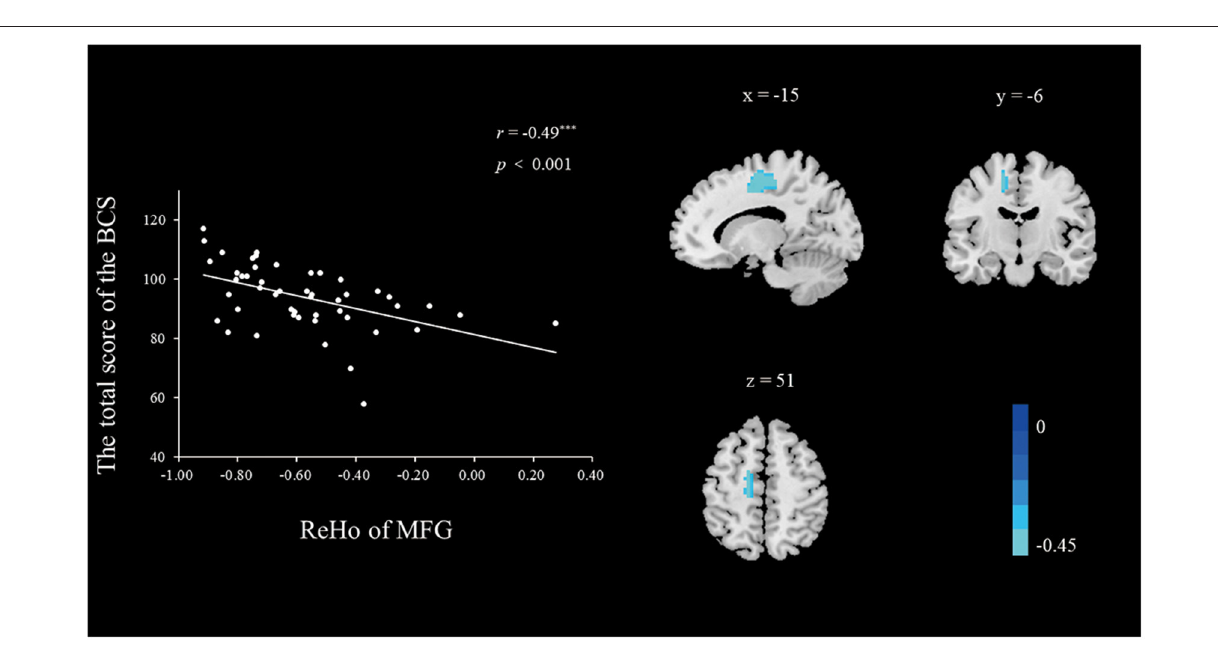
FIGURE 2 | The brain regions with significant correlations between the ReHo and the BCS (right panel). The ReHo in the left MFG was negatively correlated with the BCS (left panel). The scatter plots depicted correlations between ReHo in the left MFG and individual differences in the BCS scores. Height and extent thresholds were set at p < 0.01,